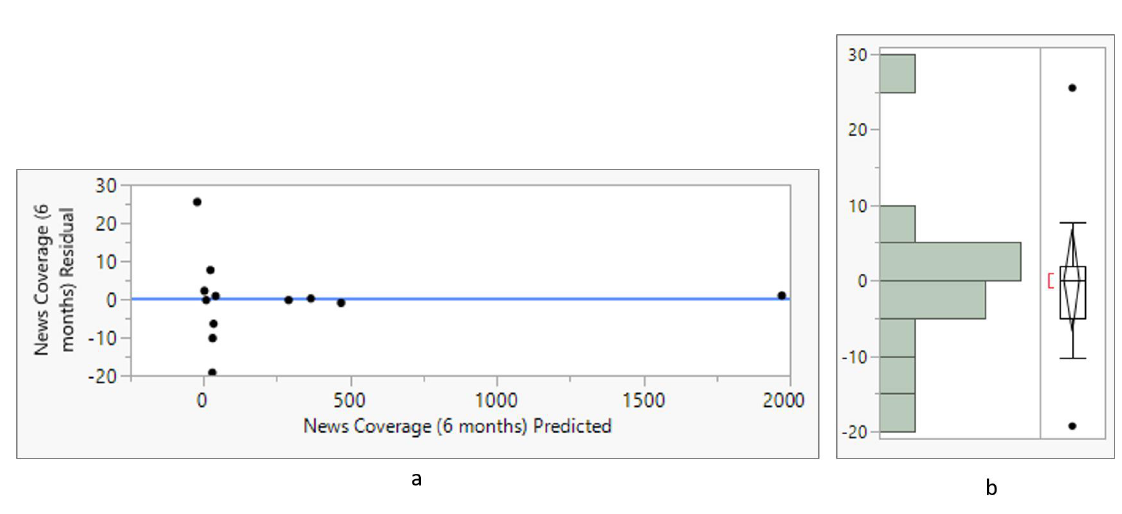
Figure 8. ( a )—Residual and ( b )—the equal spread condition